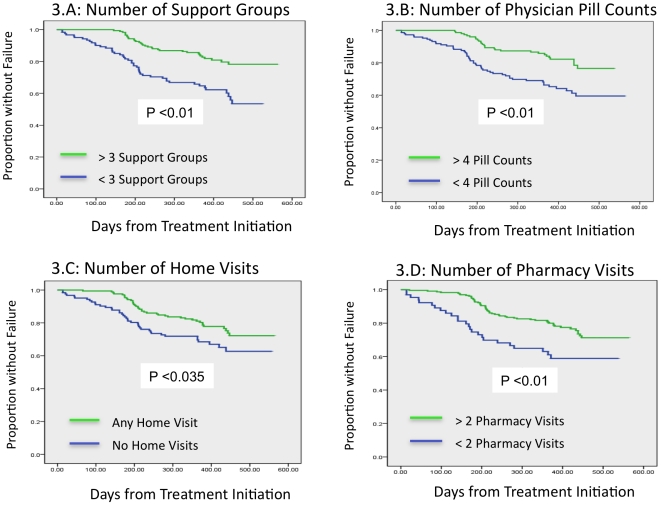
Time to Treatment Failure Categorized by Interventions.Kaplan Meier plots of time to treatment failure stratified by: A) participation in two or more support group meetings; B) having four or more unannounced pill counts by primary care provider; C) at least one home visit; D) having two or more counseling sessions by a pharmacist.